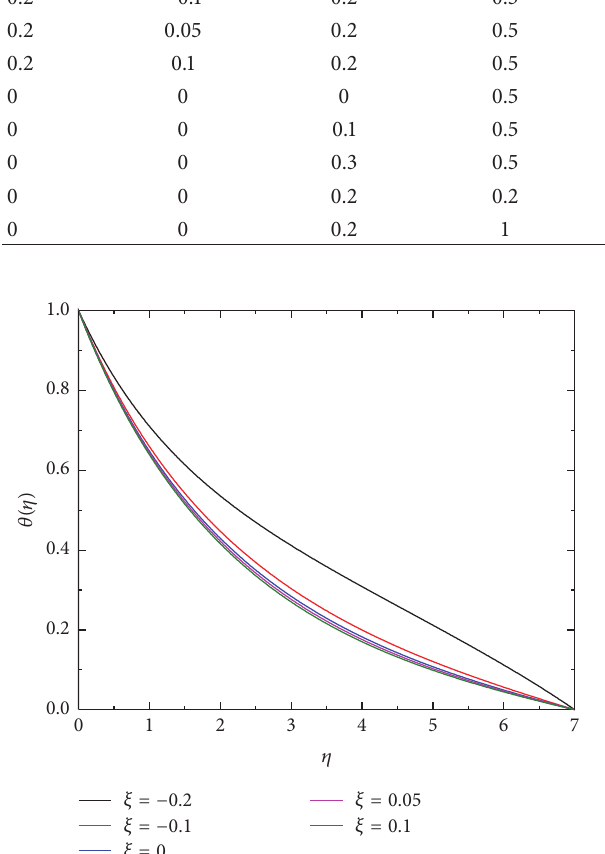
Figure 14: Temperature profiles for various values of 𝜉 when 𝐴 = 0.2 , 𝑅 = 0.5 , and 𝐾 = 0.2